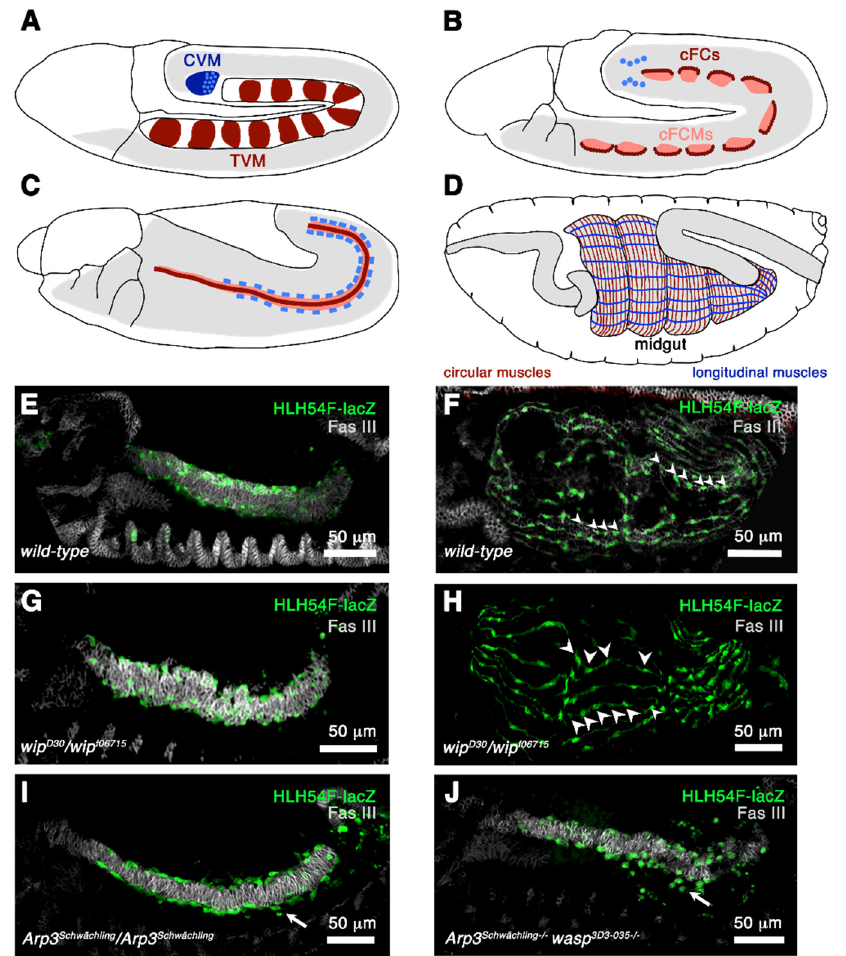
Figure 5. Formation of circular and longitudinal muscles. ( A – D ) Schematically drawn stages 10, 11, 12, and 16 embryos. Lateral view. ( A ) At stage 10 there are 11 cell clusters in the dorsal mesoderm that contain the primordial cells of the circular muscles and the longitudinal visceral muscles ( red ). These cells give rise to the trunk mesoderm (TVM). The caudal visceral mesoderm (CVM) gives rise to the longitudinal midgut muscles and is drawn in blue. ( B ) At stage 11, a single row of the visceral trunk primordia is specified and develops into founder cells ( red ). The rest of the cells evolve into fusion-competent myoblasts ( rose ). Additionally, the cells of the caudal visceral mesoderm leave their position at stage 11 and migrate onto the posterior cells of the trunk mesoderm on either side of the embryo. ( C ) At stage 12 the trunk visceral muscle founder cells fuse with fusion-competent myoblasts and form binucleated cells. The cells of the caudal visceral mesoderm are now circular founder cells and fuse with the fusion-competent myoblasts of the trunk mesoderm during migration. ( D ) Circular and longitudinal muscles are required for normal midgut constrictions. ( E , F ) Stages 13 and 16 embryos stained with anti-FAS III to visualize circular muscles ( grey ) and with anti- β -Galactosidase to mark caudal visceral founder cells expressing HLH54-lacZ. ( E ) Stage 13 embryo. Longitudinal founder cells have migrated on the trunk mesoderm. ( F ) Stage 16 embryo with multinucleated longitudinal muscles. Arrowheads point to the nuclei. ( G ) In wip homozygous mutants the migration of longitudinal founder cells and ( H ) myoblast fusion is not affected ( arrowheads ). ( I ) In homozygous Arp3 mutants the longitudinal founder cells sometimes fail to migrate along the trunk mesoderm ( arrow ). ( J ) This phenotype is enhanced when homozygous Arp3 wasp double